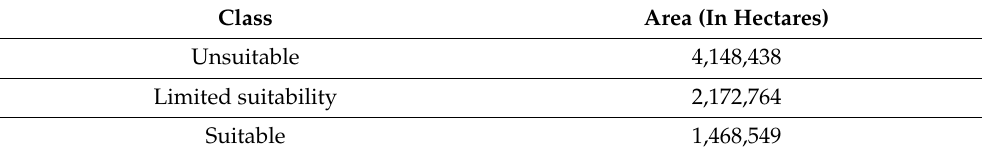
Table 7. Area of land unsuitable/limited/suitable for Sitka spruce based on biophysical factors.